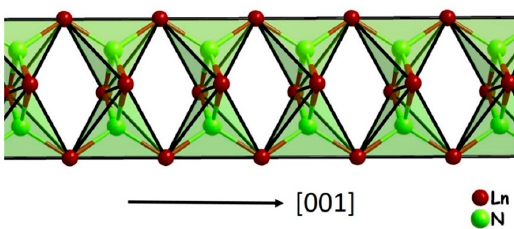
Figure 3. Linkage of tetrahedral [N Ln 4 ] 9+ units via edges to dimers [N 2 Ln 6 ] 12+ and their linear vertex connection to 1 ∞ {[N( Ln 1) e ( Ln 2) v ] 3+ } strands along [001] in the crystal structure of the A-type 2/2 2/2 Ln 4 N 2 S 3 series ( Ln = La–Nd).